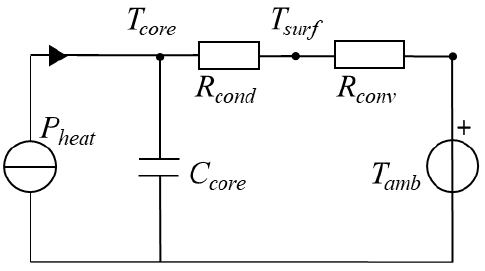
Figure 5. Equivalent electrical circuit for the lithium cell.